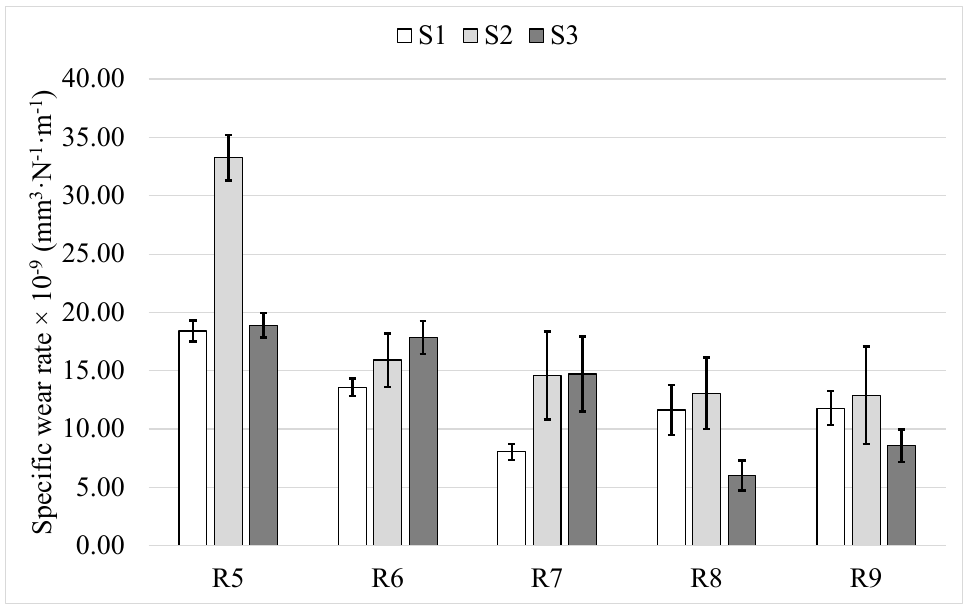
Figure 3. Specific wear rates from all fifteen ball-on-disc tests conducted at various wear track radii. To further highlight the consistency of the specific wear rate results regardless of angular velocity, omitting the three above mentioned outlier values, the calculated average value of the specific wear rate and the maximum standard deviation that can occur